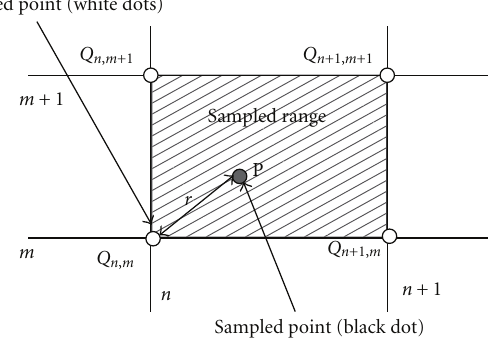
Figure 2: Schematic representation of the building lookup